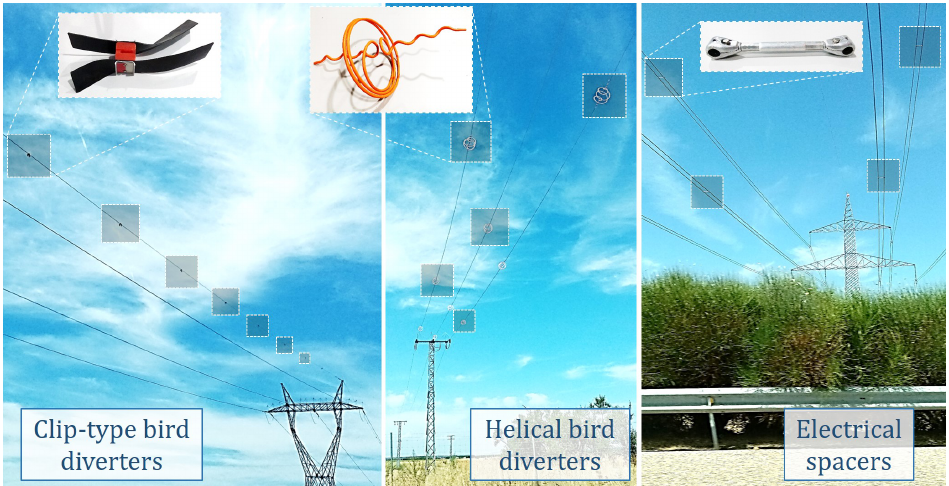
Figure 1. Three devices typically installed on the power